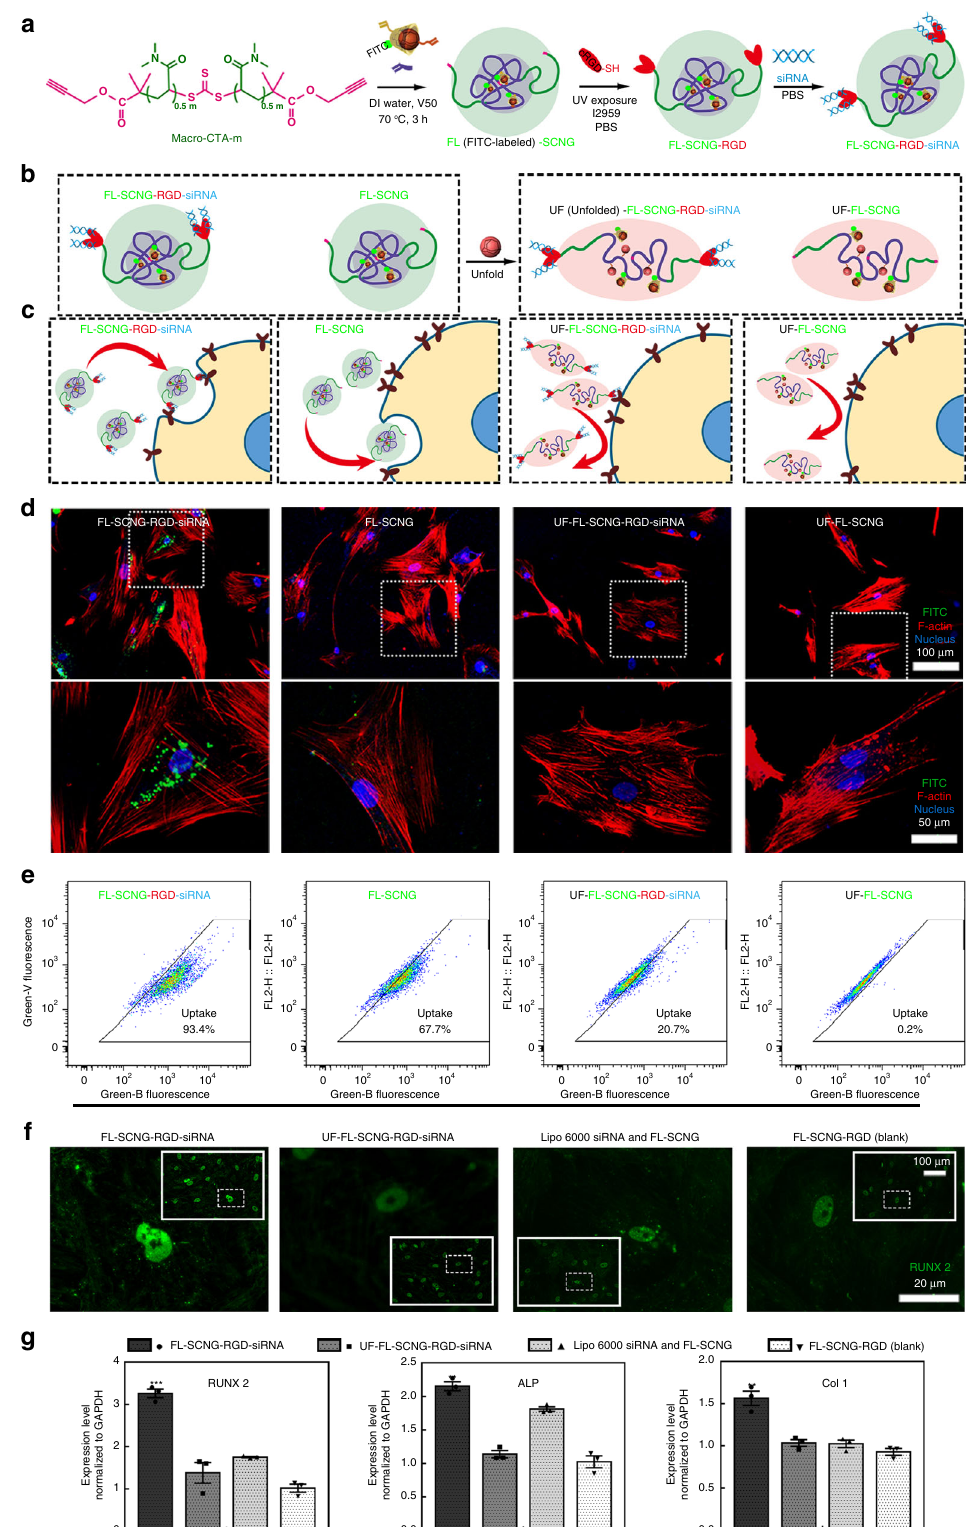
spread cells (Fig. 5d, e). In sharp contrast, cells hardly attached and spread on the substrate conjugated with the control group of non-foldable linear chain polymer linkers (CD-LCP-RGD). This indicates that the large tether length of RGD does not favour focal adhesion and spreading (Fig. 5). On the substrate conjugated with